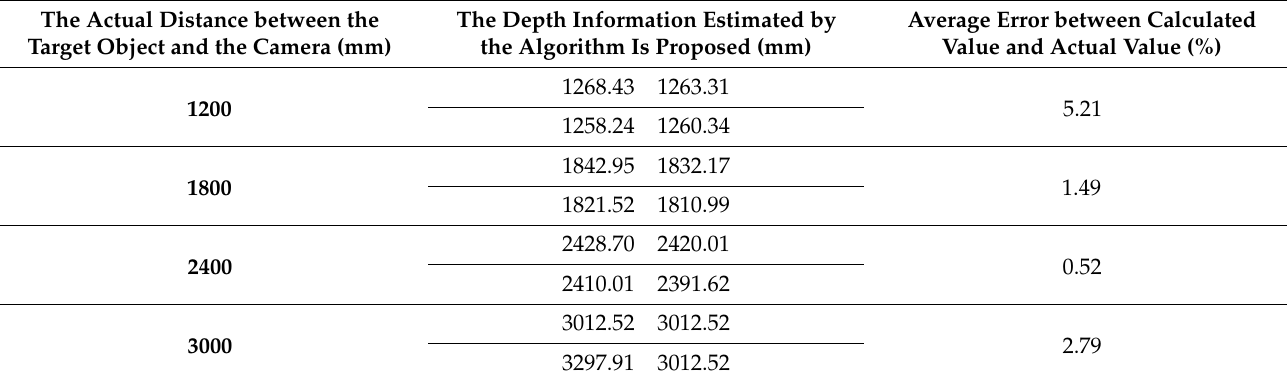
Table 2. Comparison of depth estimation at different distances. The Actual Distance between the Target Object and the Camera